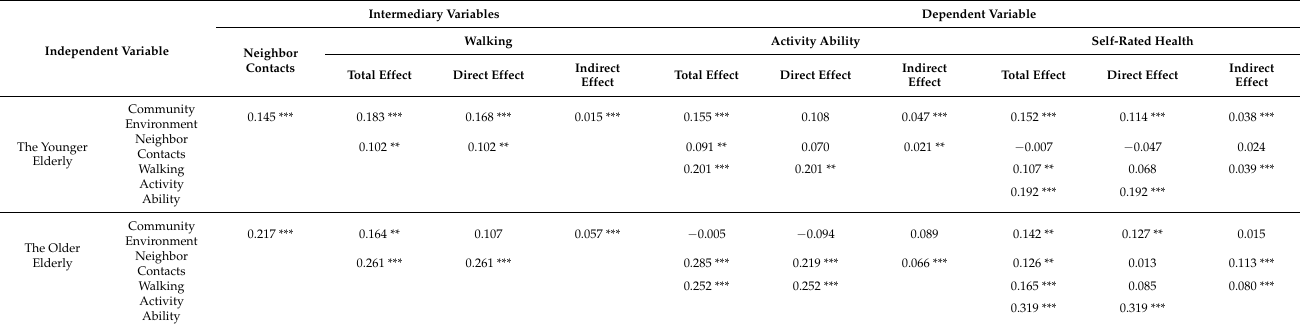
Table 3. Comparison of the model paths in different age